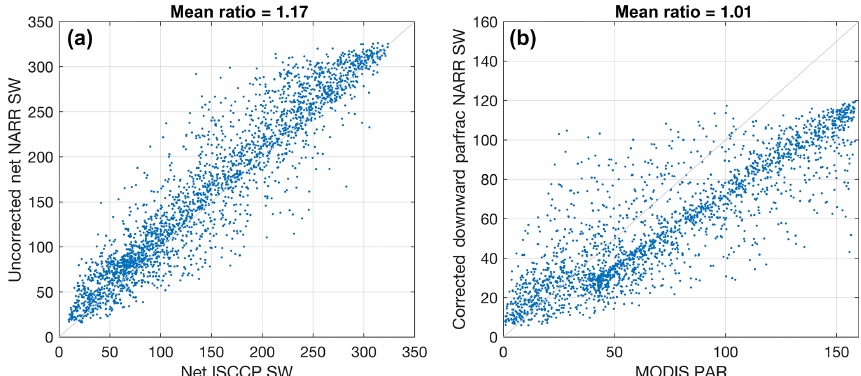
Figure 2. (a) Net NARR shortwave daily-averaged data uncorrected for overestimation compared to ISCCP net shortwave (SW) data; mean ratio indicates 17% overestimation. (b) NARR shortwave data with a 23% reduction for overestimation (Wang et al., 2012) and a 6% reduction for albedo (Payne, 1972) and assuming a fraction of PAR (parfrac) of 0.45 (Kirk, 2010) compared to MODIS satellite PAR.